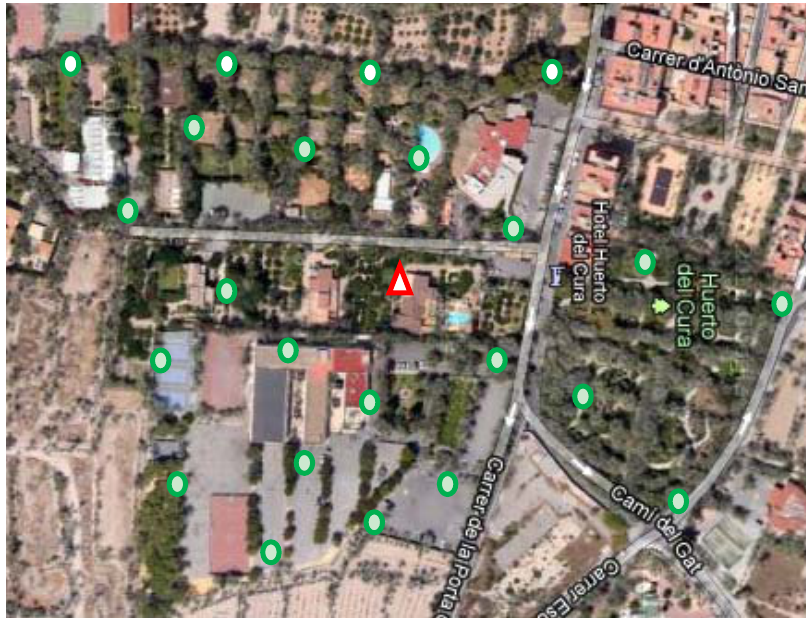
Figure 1. An example of trap deployment. Each circle represents a trap equipped with wireless image sensor. The triangle in the middle represents the location of the control